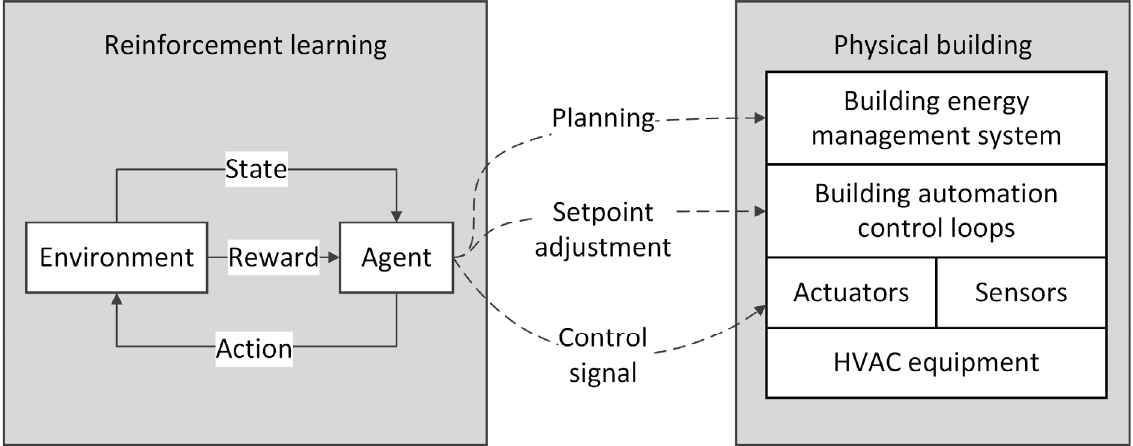
Figure 9. Main gap being filled by this review. The main gap being filled by this review is illustrated by the dashed lines in Figure 9, which map the action output of the RL agent to different systems in the physical